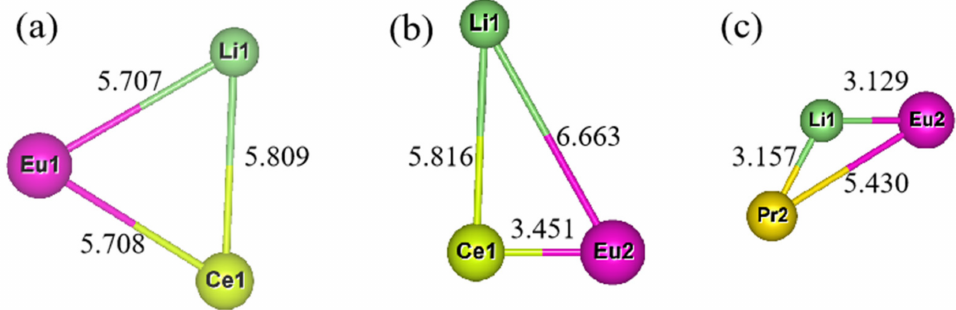
Figure 3. ( a – c ): Ln-Li, Eu-Li, Eu-Ln’s distance diagram after Eu Sr1 Ce Sr1 Li Sr1 -Sr 2 Si 5 N 8 , Eu Sr2 Ce Sr1 Li Sr1